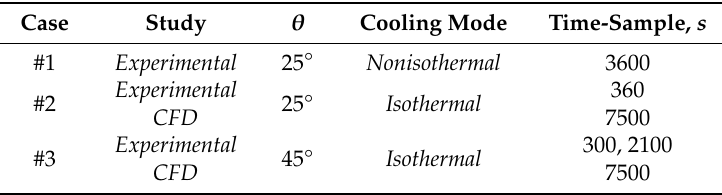
Table 1. The list of cases considered.